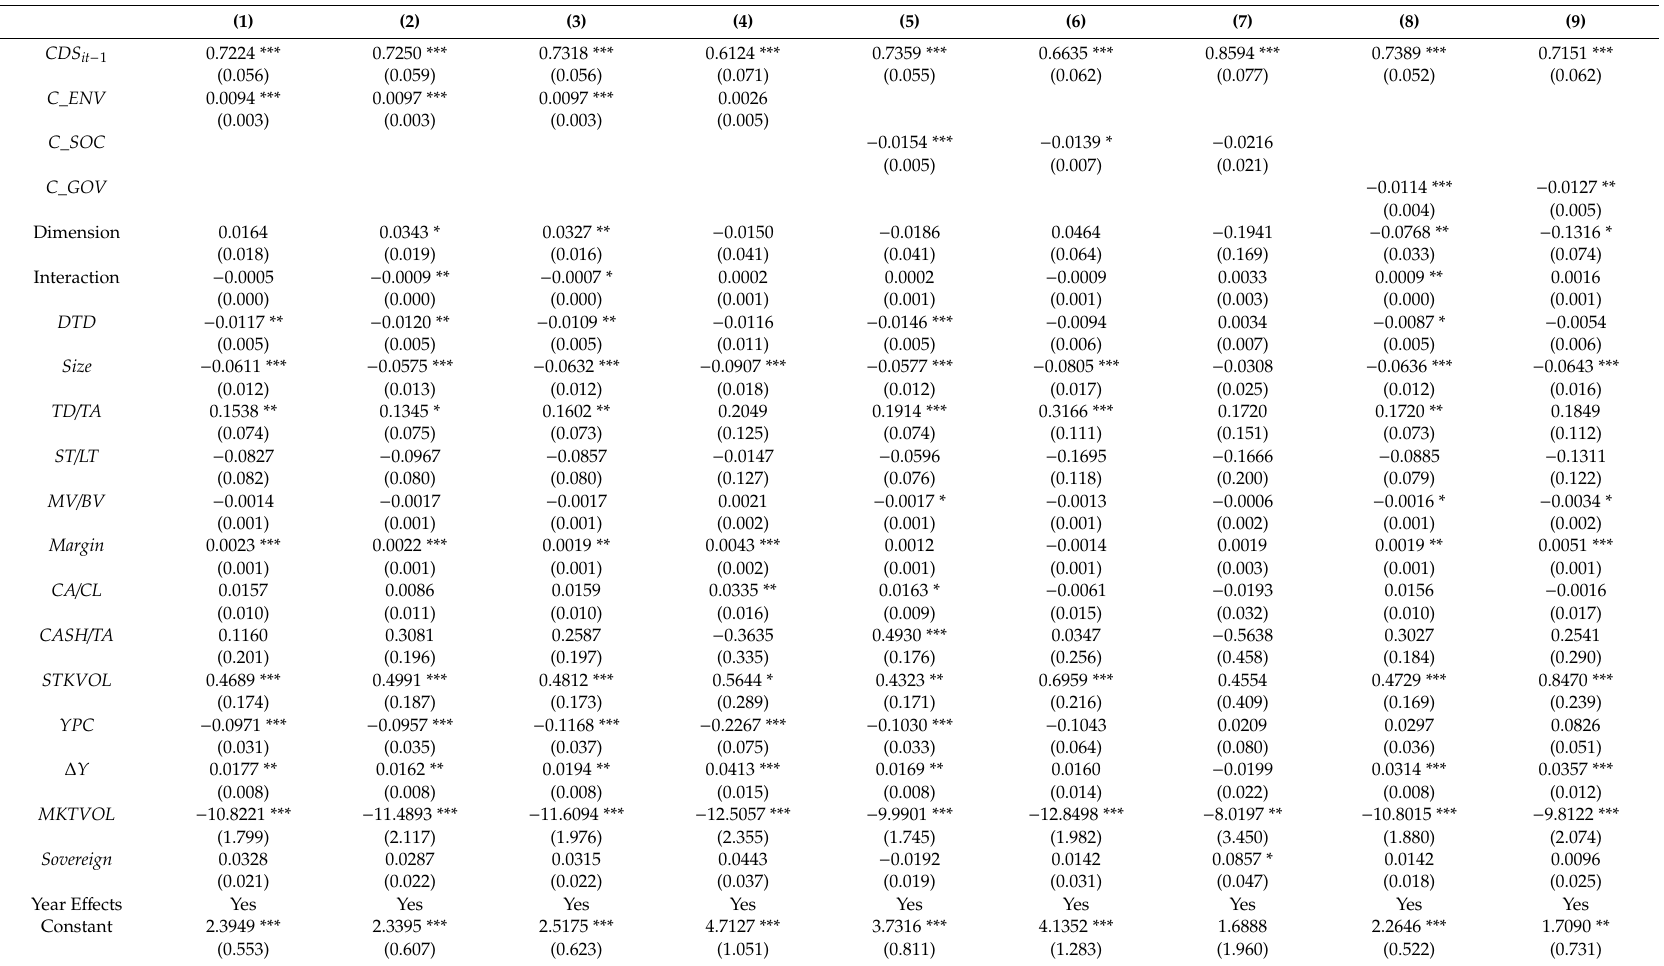
Table 6. System GMM estimation results for e ff ects of corporate social performance (CSP) dimensions and its interaction with pillar-level country sustainability on corporate default swap (CDS) spreads.